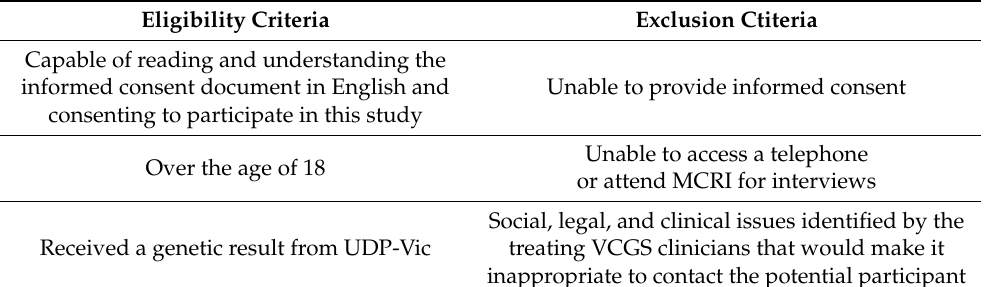
Table 1. Eligibility criteria used to assess the suitability of potential